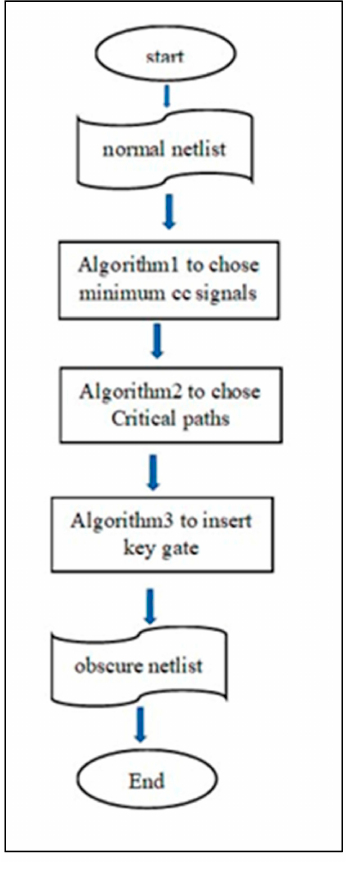
Figure 10. Steps of implementing the proposed technique (SILL).